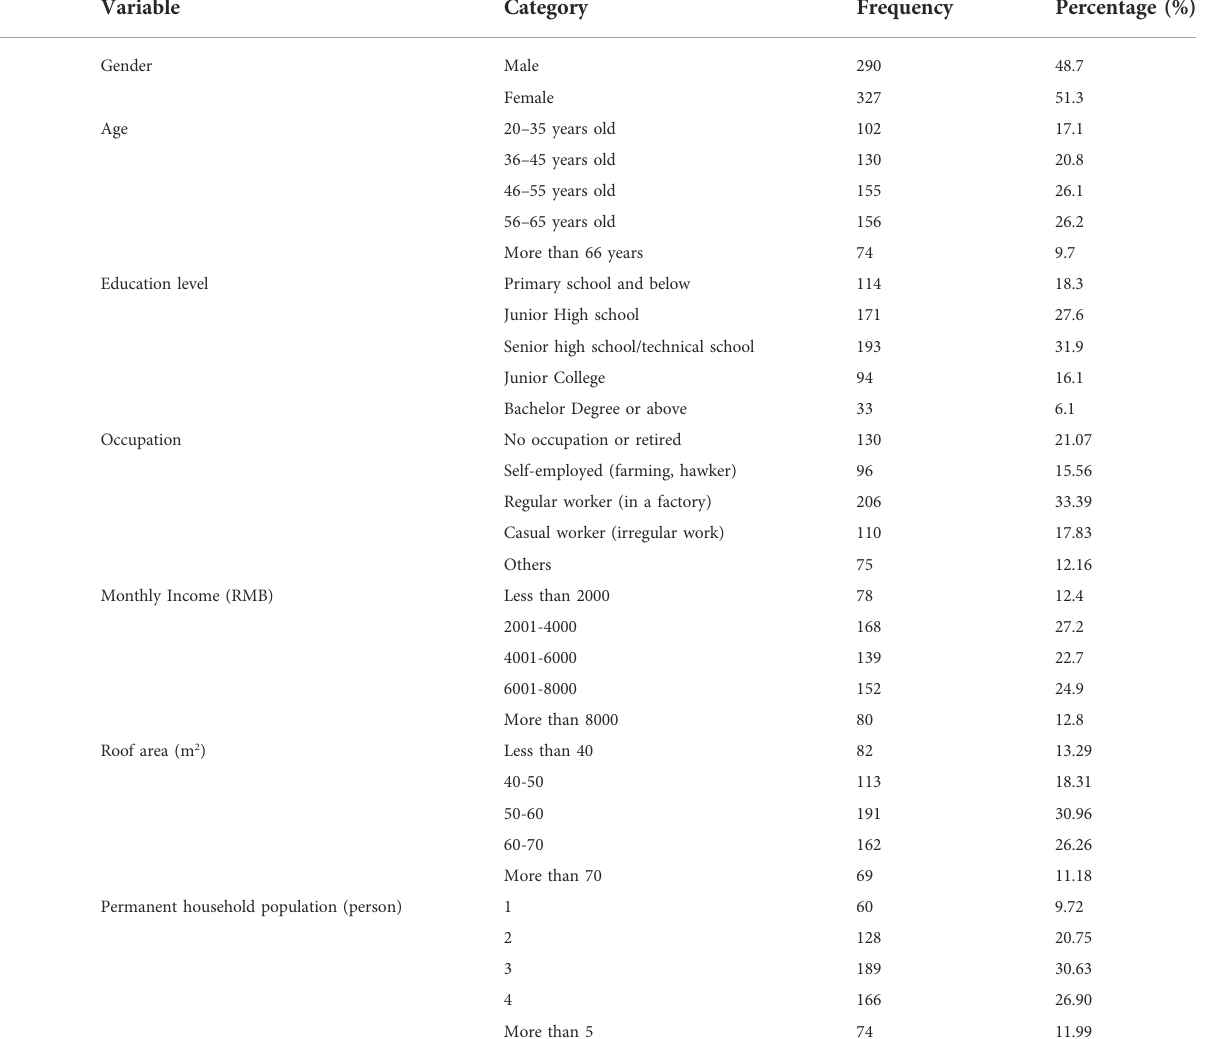
TABLE 1 Demographic information statistics of respondents (N =